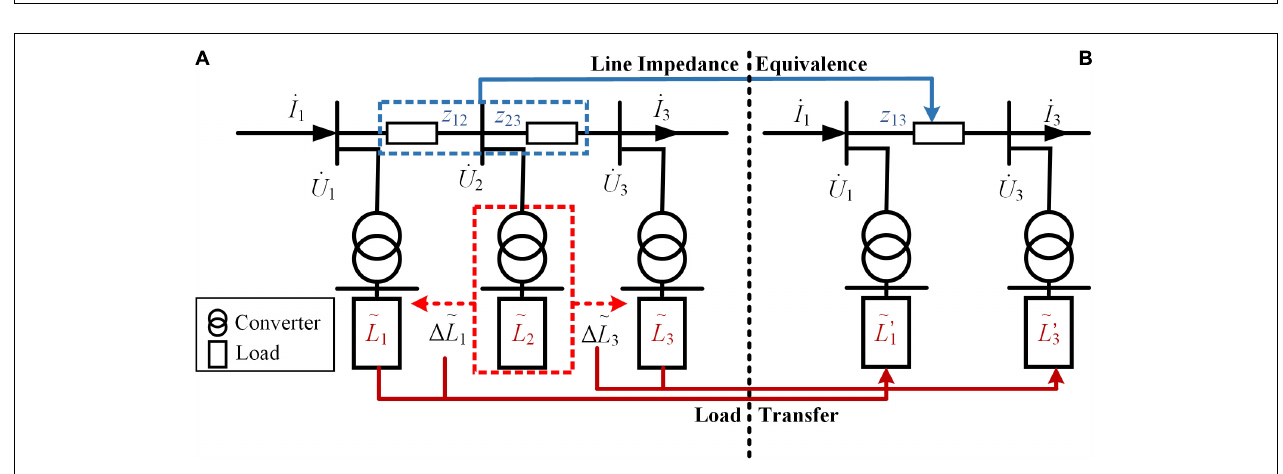
FIGURE 3 | Schematic diagram of feeder equivalence. (A) Original feeder (B) equivalent